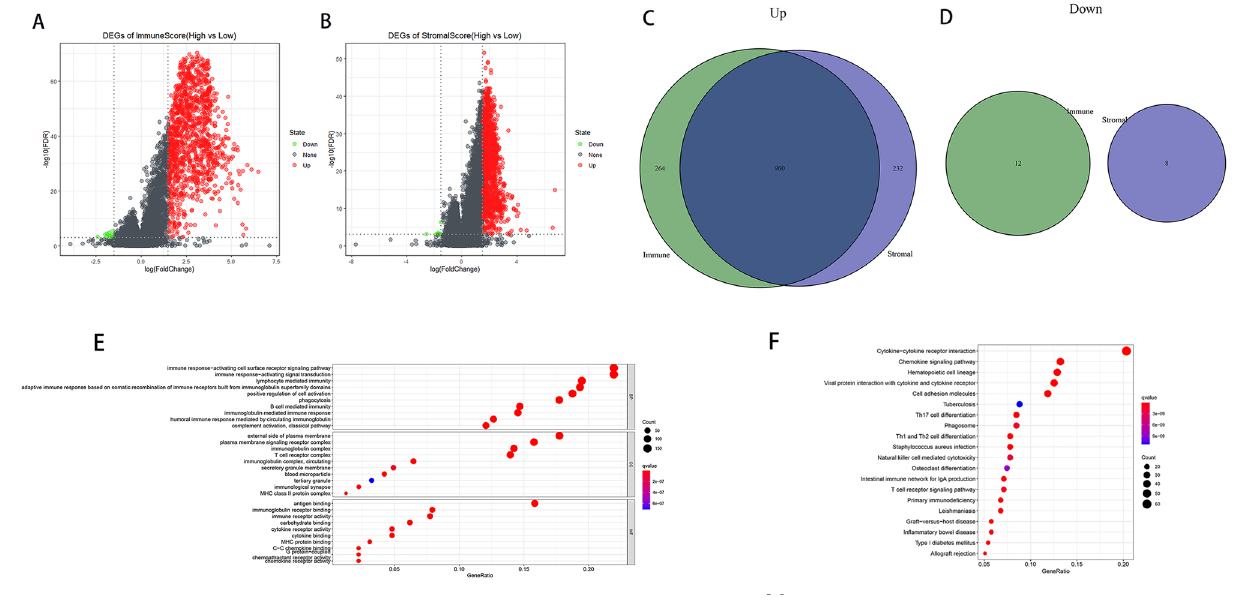
Figure 4. Volcano plots, Venn diagrams, and GO and KEGG enrichment analyses of DEGs. Volcano plots of significant DEGs (FDR-adjusted P < 0.001, |log2(fold change)| > 1.5) between high and low ( A ) ImmuneScore and ( B ) StromalScore groups. ( C , D ) Venn diagrams of upregulated and downregulated DEGs that were shared by the ImmuneScore and StromalScore analyses. ( E ) GO and ( F ) KEGG enrichment analyses (p < 0.05 and q < 0.05). This figure was generated using “limma”, “ggplot2”, “clusterProfiler”, and “enrichplot” R packages. We have got permission to use the KEGG software from the Kanehisa laboratory (http:// www. kegg. jp/ kegg/ kegg1. html) 15